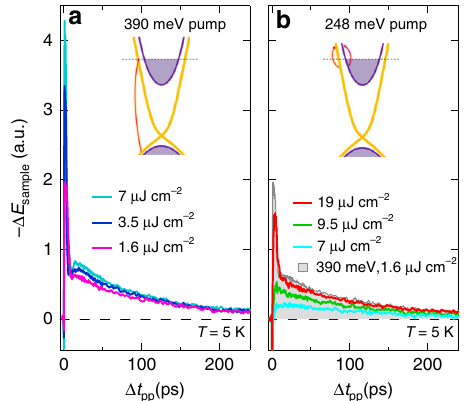
Fig. 6 Ultrafast THz dynamics under interband and intraband photoexcitations. Pump-induced THz fi eld changes Δ E sample as a function of pump-probe delay Δ t pp after a 390 meV (3.18 μ m) and b 248meV (5 μ m) photoexcitations at various fl uences and T = 5 K. The gate time t gate is fi xed at the peak of the static THz fi eld shown in Fig. 1d. One of the THz traces from a (pink curve, 1.6 μ J cm − 2 ) is also plotted in b as a fi lled gray curve for better